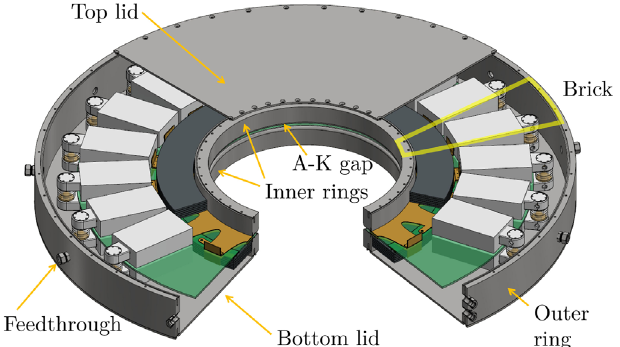
FIG. 1. A view of one of the cavities of HADES. Twenty-two bricks (composed of one spark gap switch and two capacitors) are connected to the inner rings via a set of strip lines (brass color). Two saturable cores (black) preclude the current from flowing inside the lid of the cavity. The inner rings and their anode- cathode (A-K) gap are surrounding the nested transmission lines, shown in Fig. 2. The insulator between the top and bottom inner rings (green) is the only electrical break between both sides of the A-K